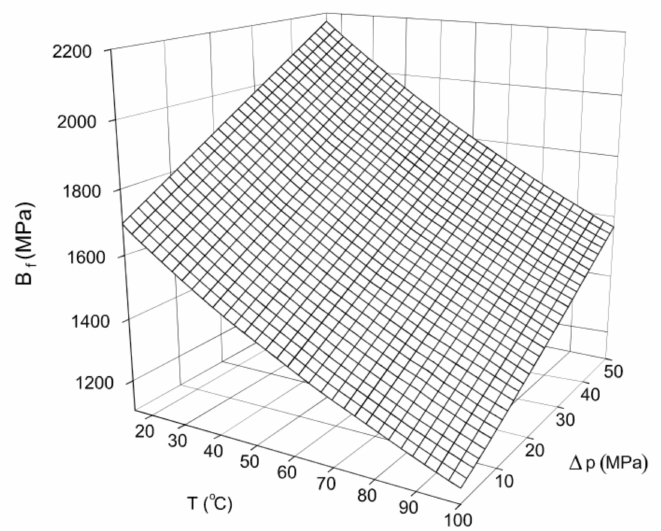
Figure 11. Isothermal bulk modulus of mineral oil in the initial drive phase; for low pressures, substantial changes in the fluid bulk modulus value might